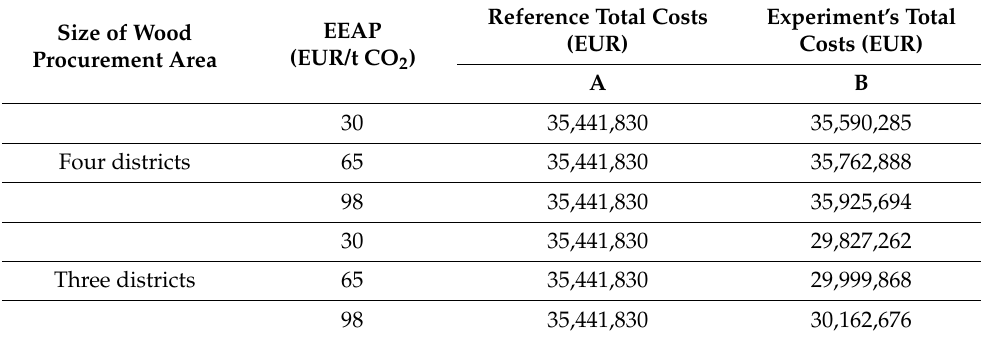
Table 1. Comparison between the reference scenario (i.e., renewable forest carbon sink) and the experimental scenario (i.e., decreasing forest carbon sink) in large wood-procurement areas (i.e., four districts) and small wood-procurement areas (i.e., three districts). A = the optimum solution of the basic scenario without the DDICPM; B = the optimum solution with the DDICPM when the carbon sink changed in the districts ( − 1.4, − 1.9, +5.3, and − 2.0%). Size of Wood